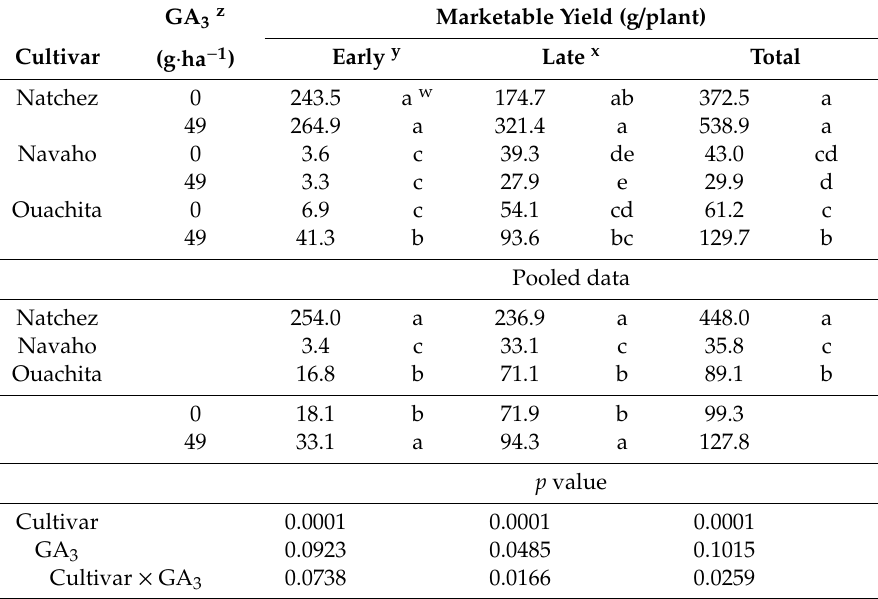
Table 2. E ff ects of gibberellic acid (GA 3 ) treatment on early-, late-, and total-season yield of ‘Natchez’, ‘Navaho’, and ‘Ouachita’ blackberry grown under subtropical climatic conditions in the 2015–2016